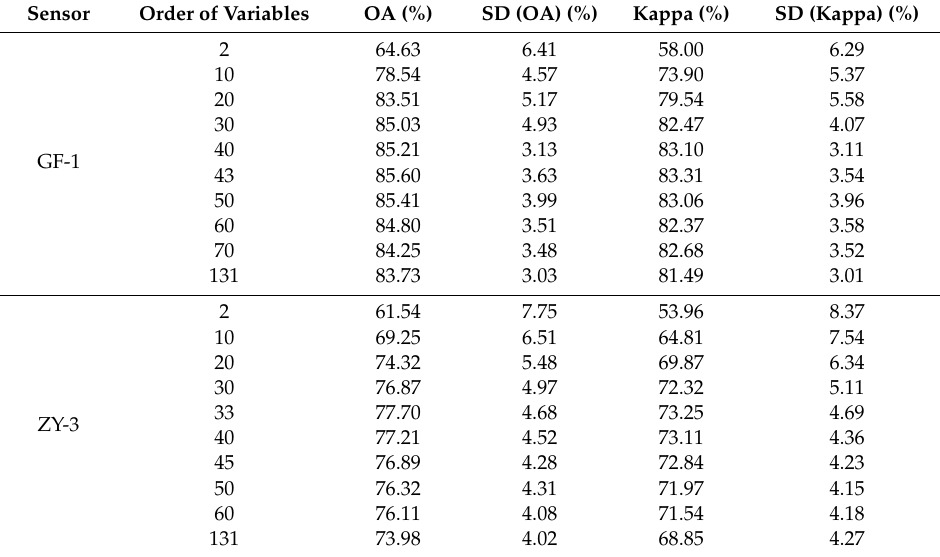
Figure 10. Input variables for scenario 4 using VSURF algorithm. ( a ) GF-1 data, ( b ) ZY-3 data. Table 9. Overall accuracy of trained RF model using VSURF-based variable selection. OA: overall accuracy; SD: standard deviation.